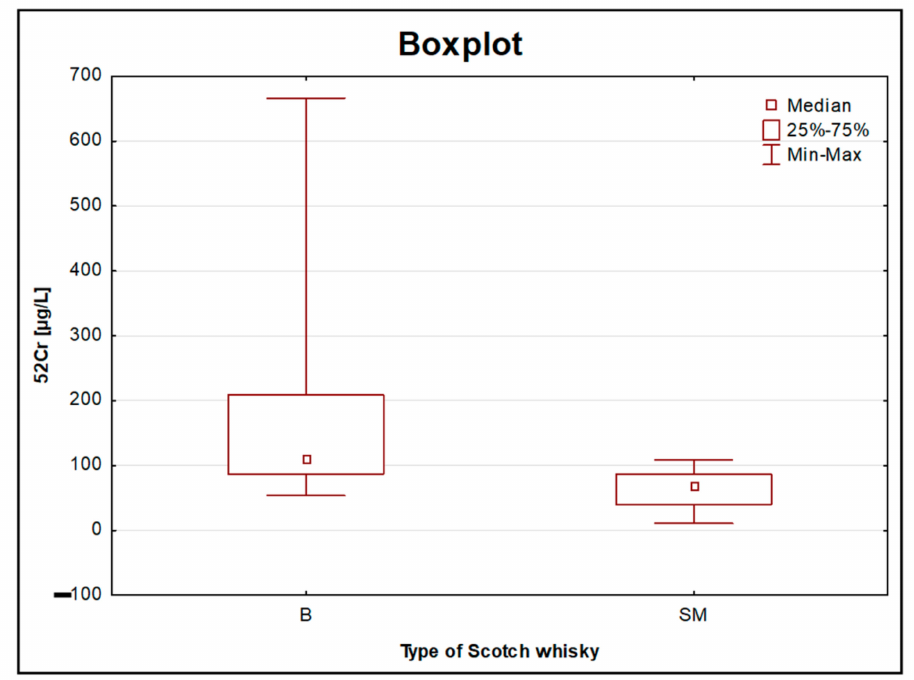
Figure 5. Boxplot for the concentration of Cr obtained for 106 objects of Scotch whisky, divided into two groups: blended (B) and single malt